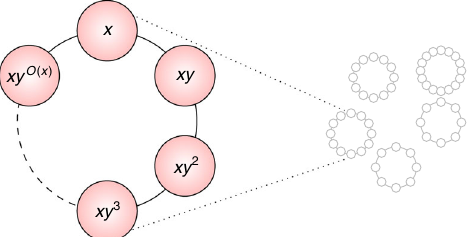
Fig. 1 A physical intuition for H N , y . Vertices are the standard basis; edge ( u , v ) represents non-zero entry of H , namely 〈 u | H N , y | v 〉 = 1 and v = uy ± 1 mod N . Multiplication by y mod N partitions the set {0, 1, … N − 1} into orbits whose (possibly exponential) sizes divide r , the order of y . H N , y corresponds to a quantum walk 52 along the